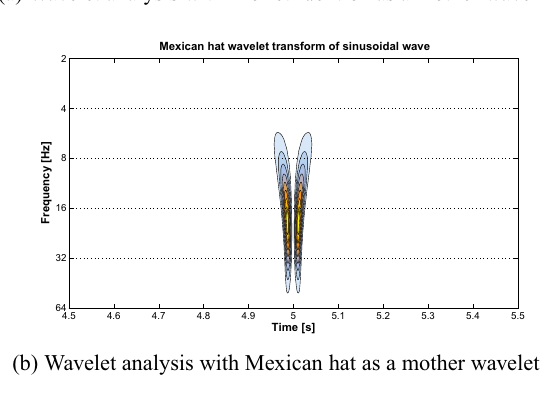
Fig. 3: Wavelet analysis of the test